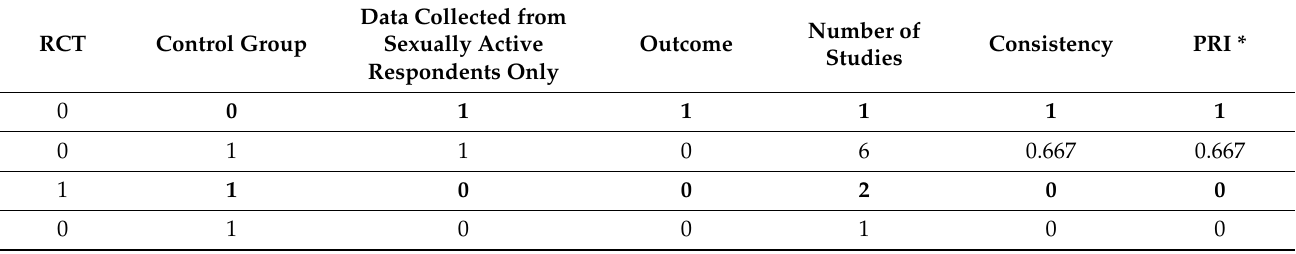
Table 3. Truth table of selected methodological